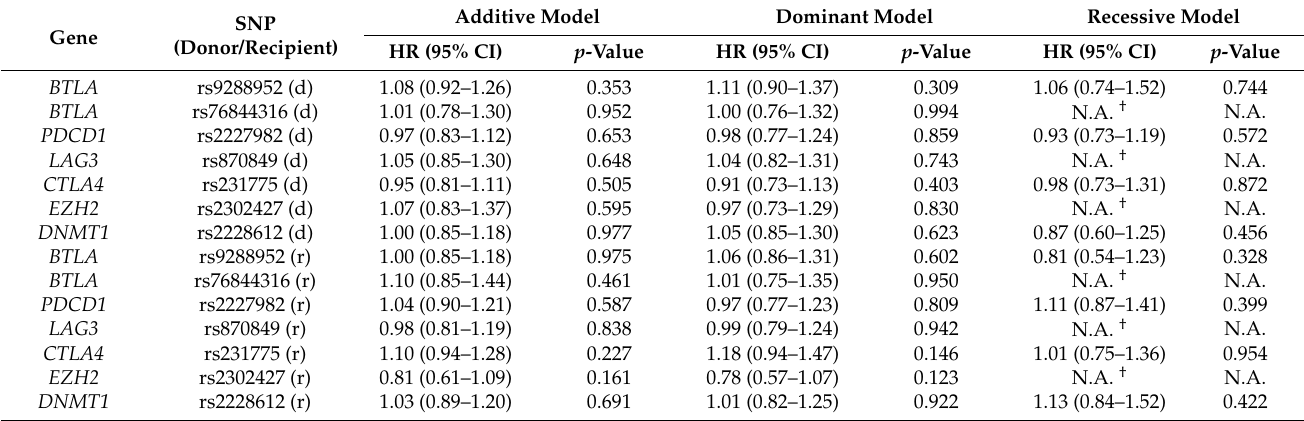
Table 5. Multivariable Cox regression of overall survival (OS) on donor and recipient